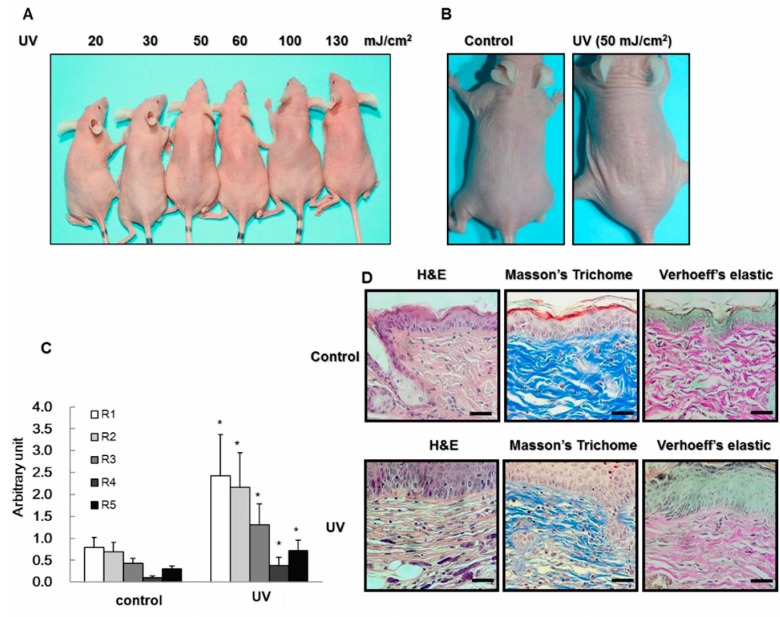
Figure 1. ( A , B ) Measurement of minimal erythema dose (MED). The intensity of ultraviolet (UV) irradiation that induced minimal erythema in the dorsal skin of hairless albino Crl:SKH1- Hrhr (SKH- 1 ) mice was 50 mJ/cm 2 ; ( C ) Wrinkle formation induced by UV irradiation. UV irradiation increased R1, R2, R3, R4, and R5 values. R1 is the distance between the highest peak and the lowest value. R3 is the average of the five maximum distances; R1 and R2 are the largest values of those five maximum distances; R5 indicates the average (arithmetic) roughness; R4 indicates smoothness depth. The data are expressed as the mean ± S.E. ( n = 5); * p < 0.05 vs. control (Student’s t -test); ( D ) Hematoxylin and Eosin (H&E) staining, Masson-Trichrome staining, and Verhoeff’s elastic staining of the dorsal skin of UV-irradiated SKH-1 hairless mice. The UV-irradiated group showed inflammation, decreased collagen fibers, and decreased elastin expression. Scale bar = 20 µ